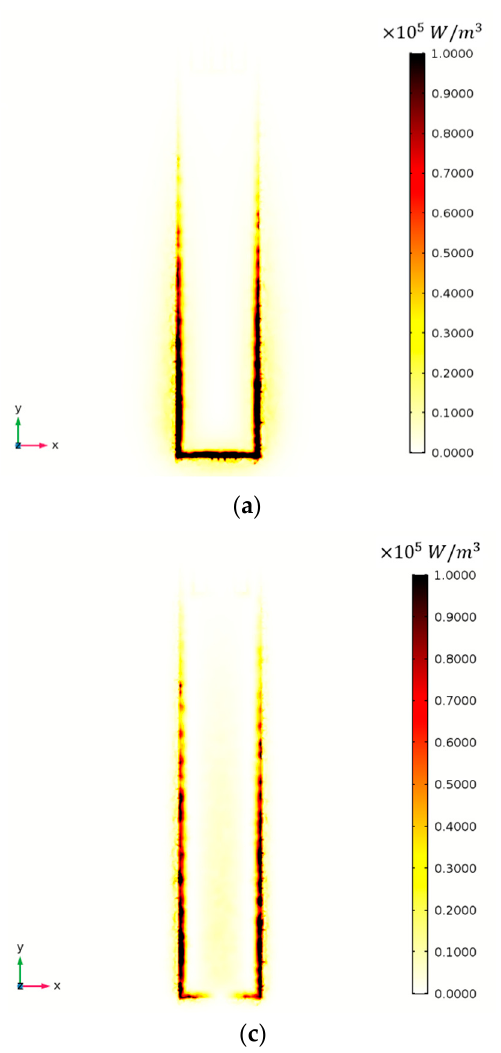
serrations in 1st Bending mode, ( c ) Viscous dissipation density around the slotted MCL in torsional